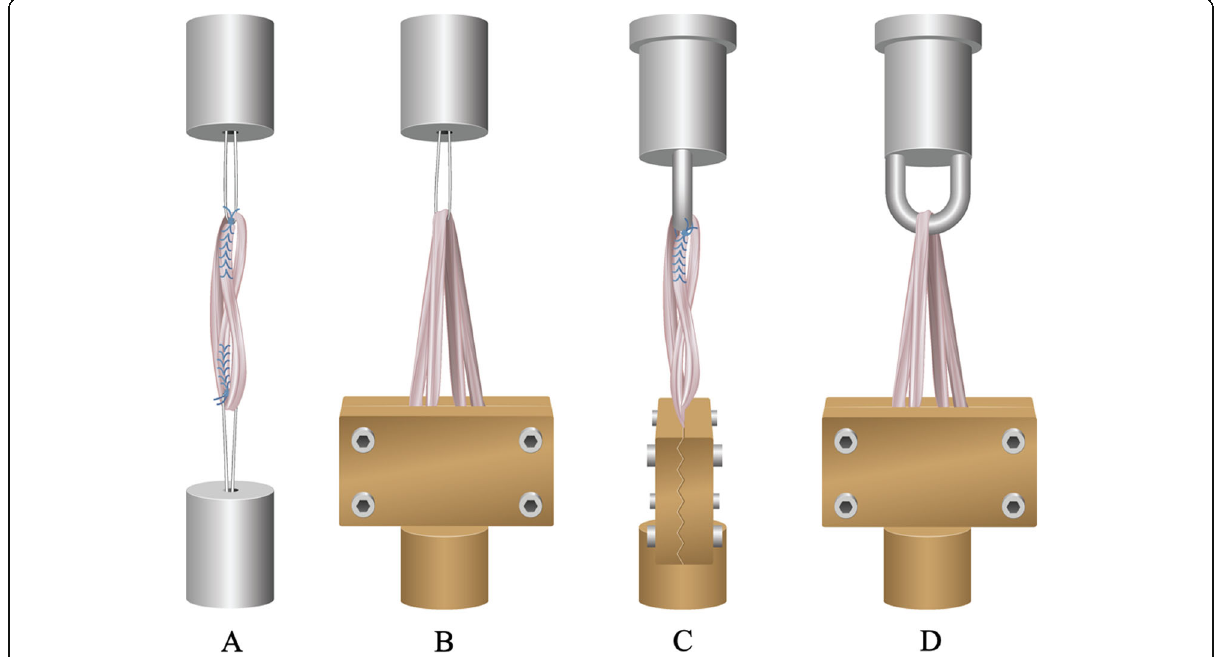
Fig. 1 Schematic view of all test groups. Group A ( a ); a tripled semitendinosus tendon (ST) graft with double TightRope fixation; Group B ( b ); a four-strand semitendinosus gracilis (STG) graft with clamp and TightRope fixation; Group C ( c ); a tripled ST graft with clamp and steel hook fixation; Group D ( d ), a four-strand STG graft with clamp and steel hook